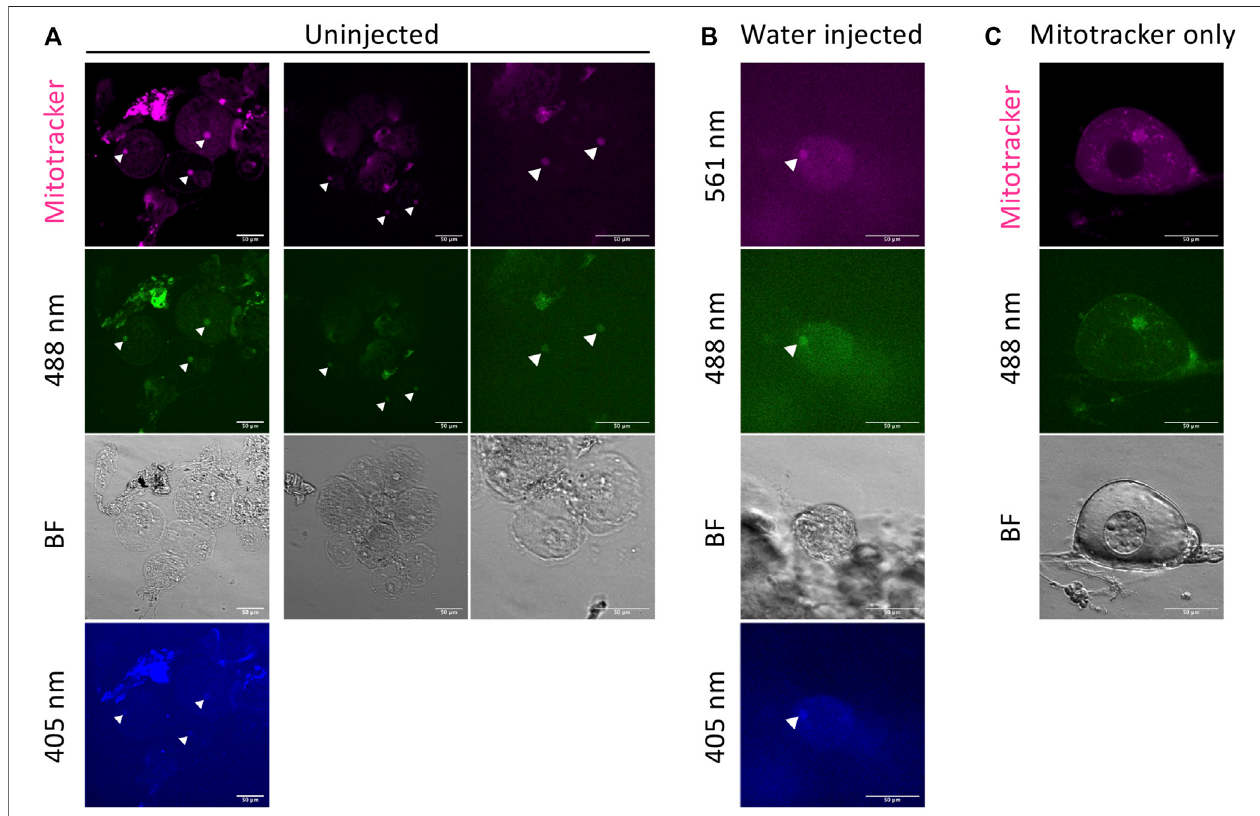
FIGURE 3 | Auto fl uorescence in damaged oocytes. Auto fl uorescence of the Bb is observed in damaged oocytes with Mitotracker (A) , and damage-induced oocytesbywaterinjectionwithoutMitotracker (B) .Arrowheadsindicatetheauto fl uorescencefromtheBb.Theauto fl uorescenceisdetectableat561,488,and405 nm wavelength channels. (C) Unexpected fl uorescence in healthy oocytes. This is likely caused by remaining fl uorescent dye (in this case, DiOC 6 for 488 nm). BF (cid:2) bright fi eld. Scale bar (cid:2) 50 μ m.